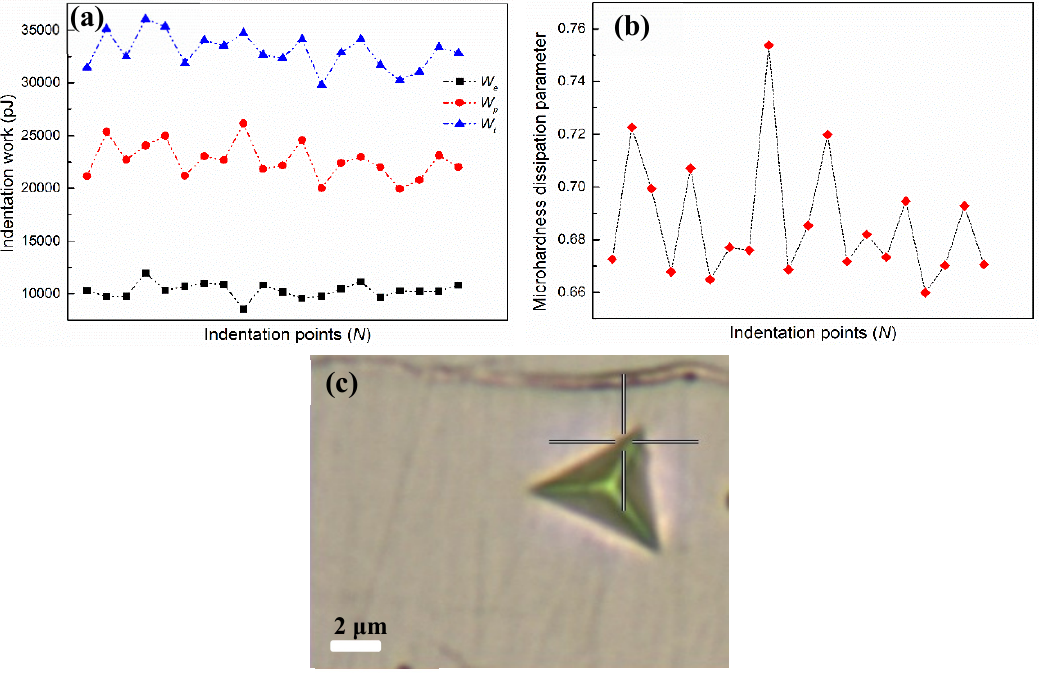
Figure 4. Indentation work ( a ), MDP ( b ), and an indentation impression at 10 gf load ( c ) of NiCoCrAlYCe coatings.